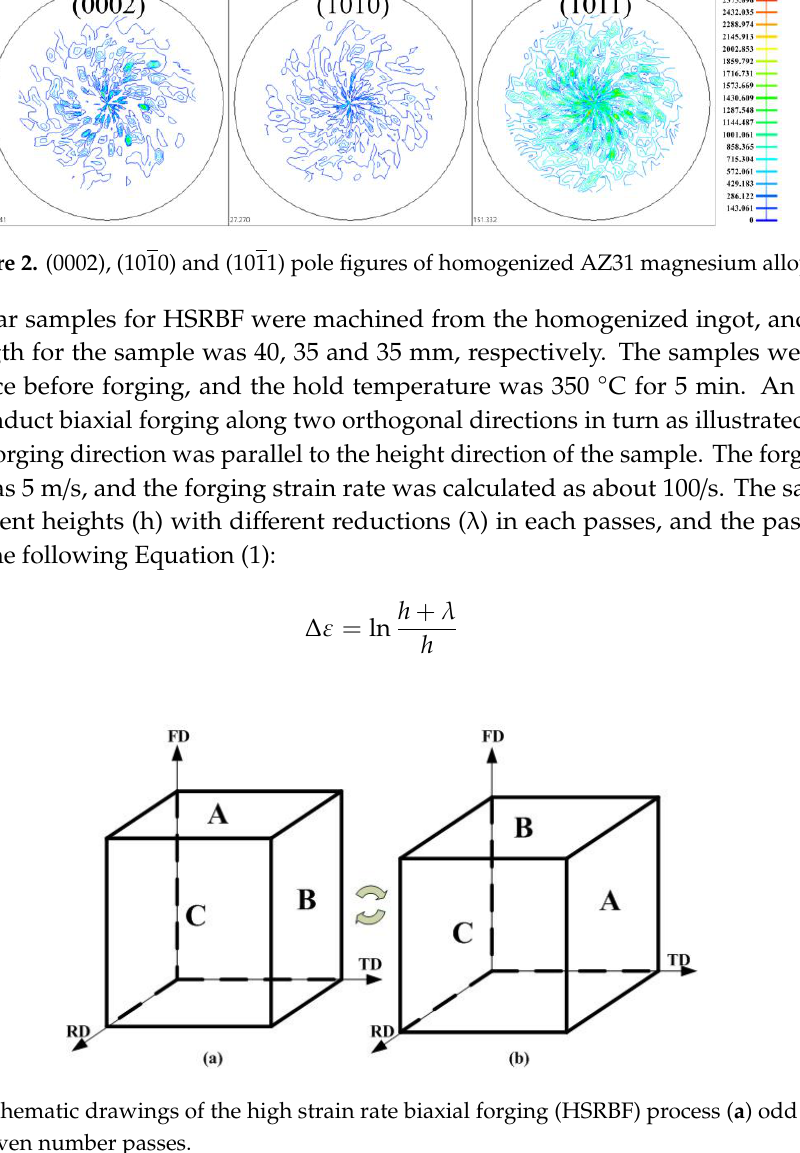
Figure 3. Schematic drawings of the high strain rate biaxial forging (HSRBF) process ( a ) odd number passes ( b ) even number passes.